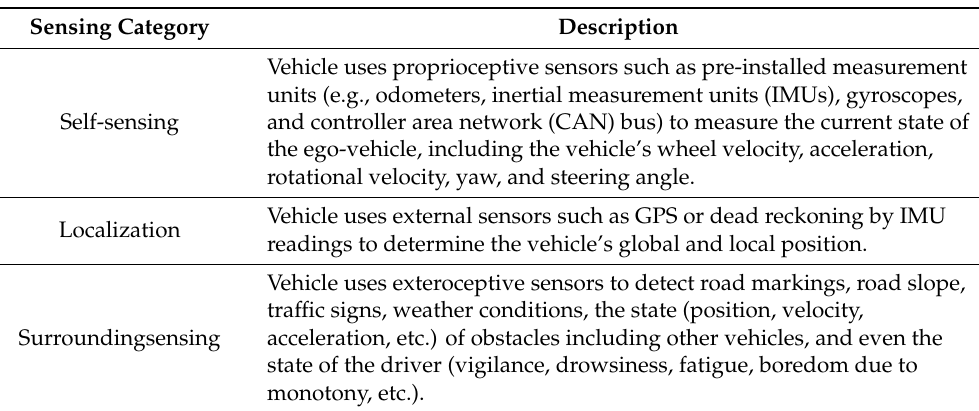
Table 2. Automotive sensing